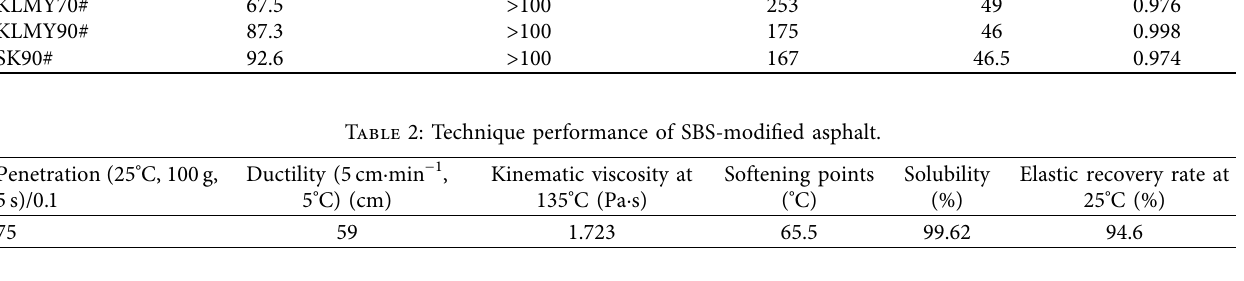
Table 3: Technique performance of SBR-modified asphalt.